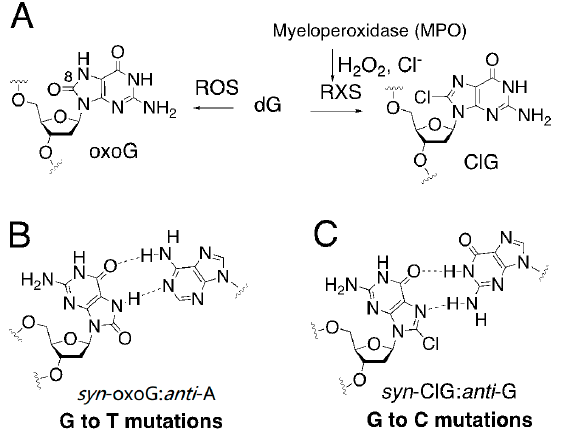
Figure 1. Promutagenicity of oxidative DNA lesions. ( A ) Generation of oxidized purines by reactive oxygen species (ROS) and reactive halogen species (RXS). ( B ) Mutagenic base pairing between 8-oxoguanine and adenine, which involves two hydrogen bonds between a syn conformer of 8-oxo-dG and an anti -conformer of dA. This mutagenic base pair can cause G to T transversion mutations. ( C ) Potential mutagenic base pairing between a syn conformer of 8-chloro-dG and an anti -conformer of dG, which can lead to G to C transversion mutations.